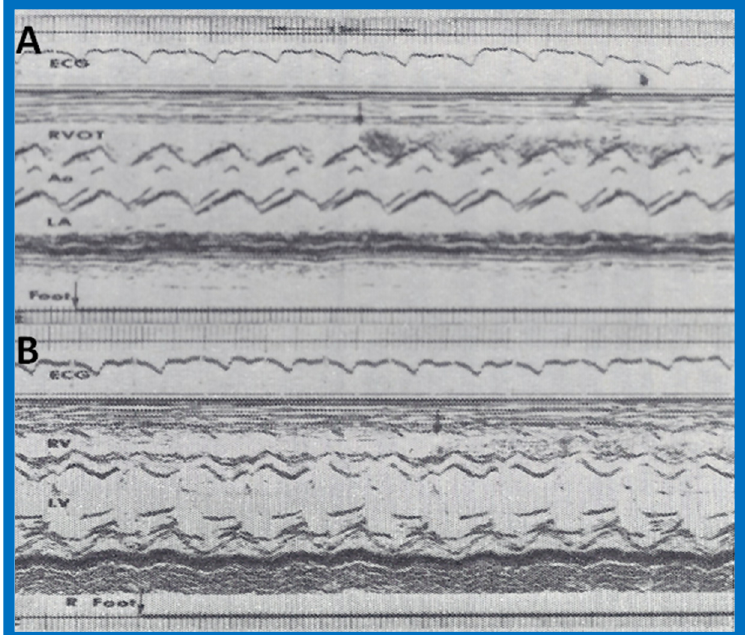
Figure 5. Recordings similar to Figure 4 were made while injecting agitated saline into the veins of the feet and these reveal contrast in the RVOT ( A ) and RV ( B ) (arrows in A and B ), suggesting that the inferior vena cava drains normally into the right atrium (not shown) and RV. The start of agitated saline injection is marked with arrows at the bottom of each tracing. ECG, electrocardiogram. Reproduced (modified) from Truman T.A., Rao P.S., Kulungara R.J. [2].